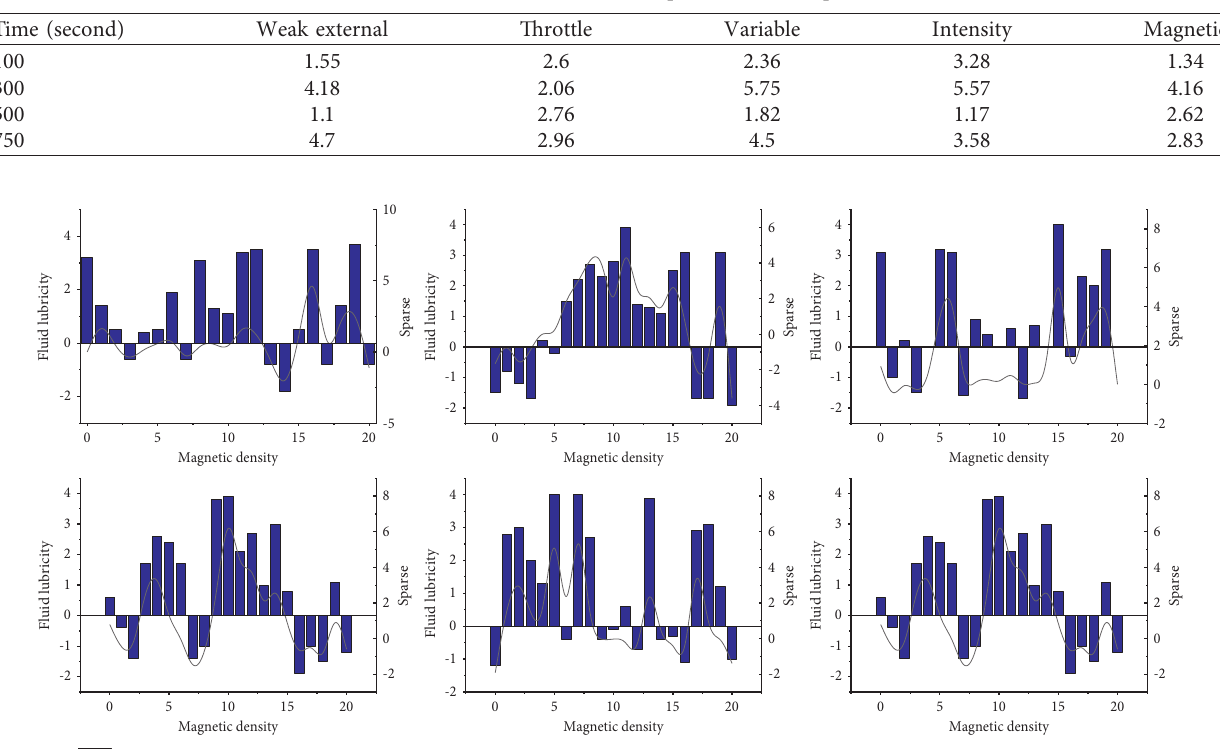
Figure 5: Lubrication of ferrofluid cancer. Table 2: Lubrication time and temperature at each point.